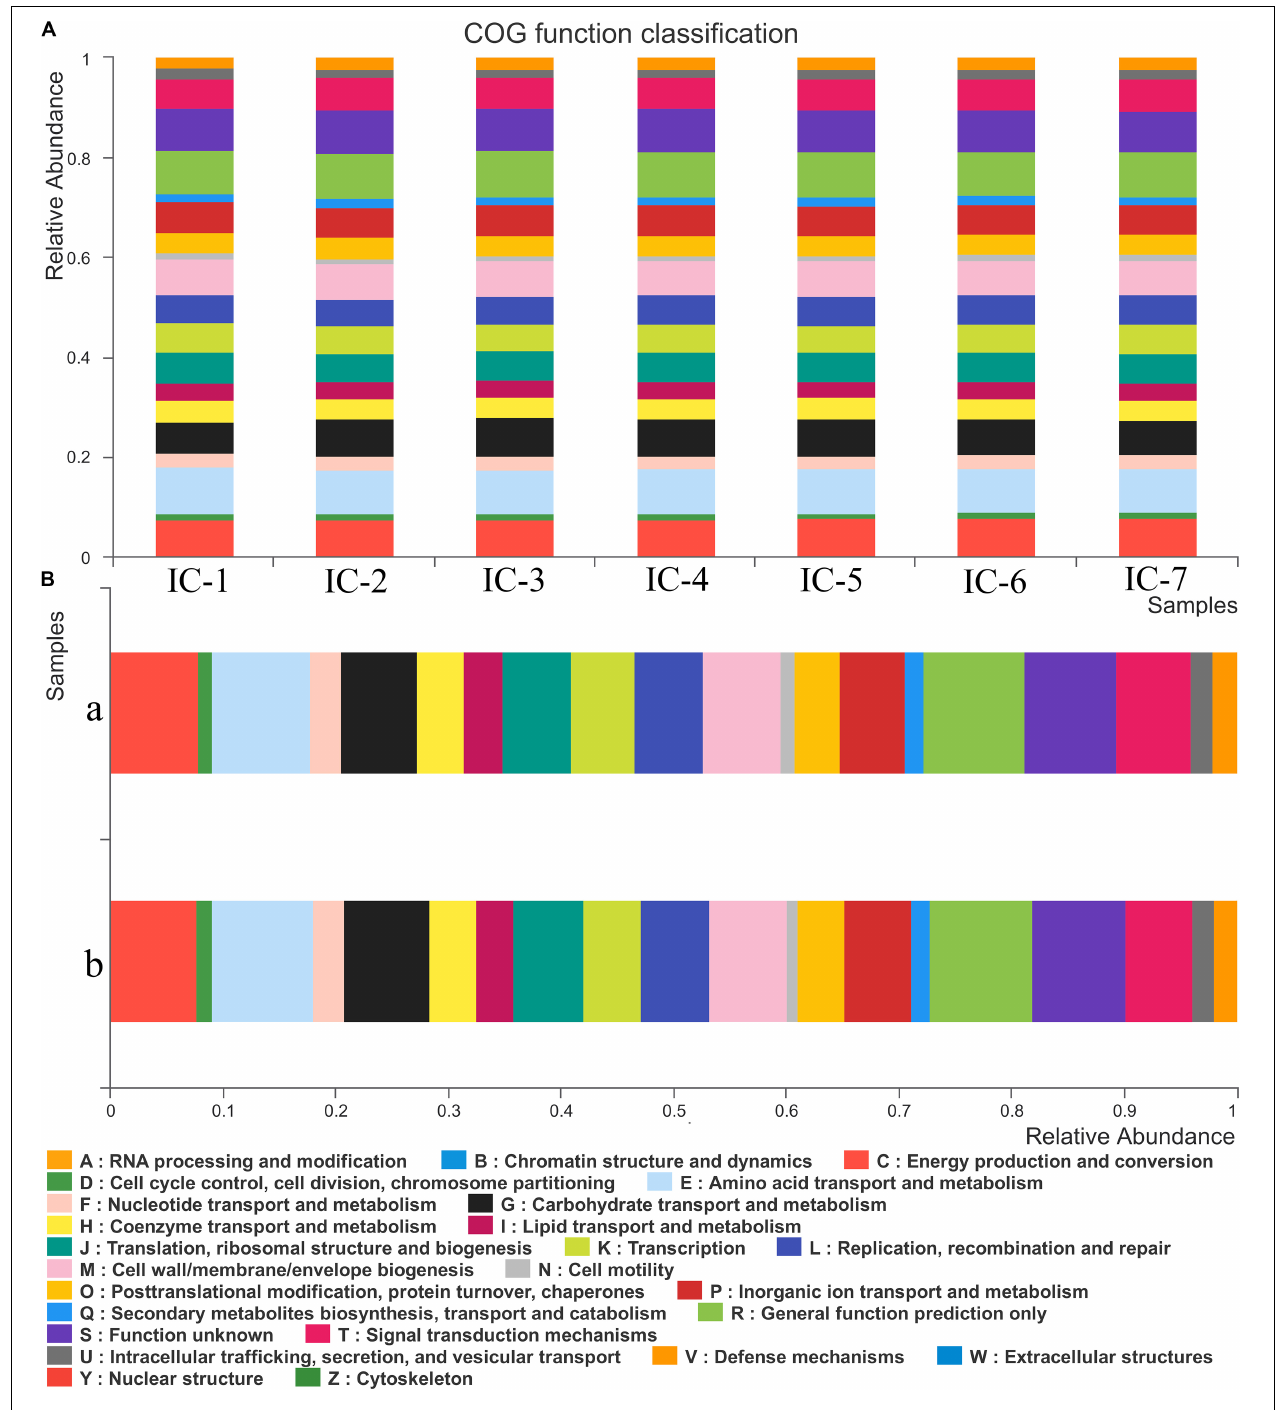
FIGURE 5 | COG function classification and abundance. (A) Sludge samples at diverse OLRs; (B) Sludge samples at different locations of the UASB reactor. IC-1, IC-2, IC-3, IC-4, IC-5, IC-6, and IC-7 represent the granular samples at OLRs of 1.43, 2.86, 4.29, 5.72, 7.15, 8.58, and 10.01 g COD/L · d. a and b represent sludge samples at different locations of UASB at OLR of 10.01 g COD/L ·